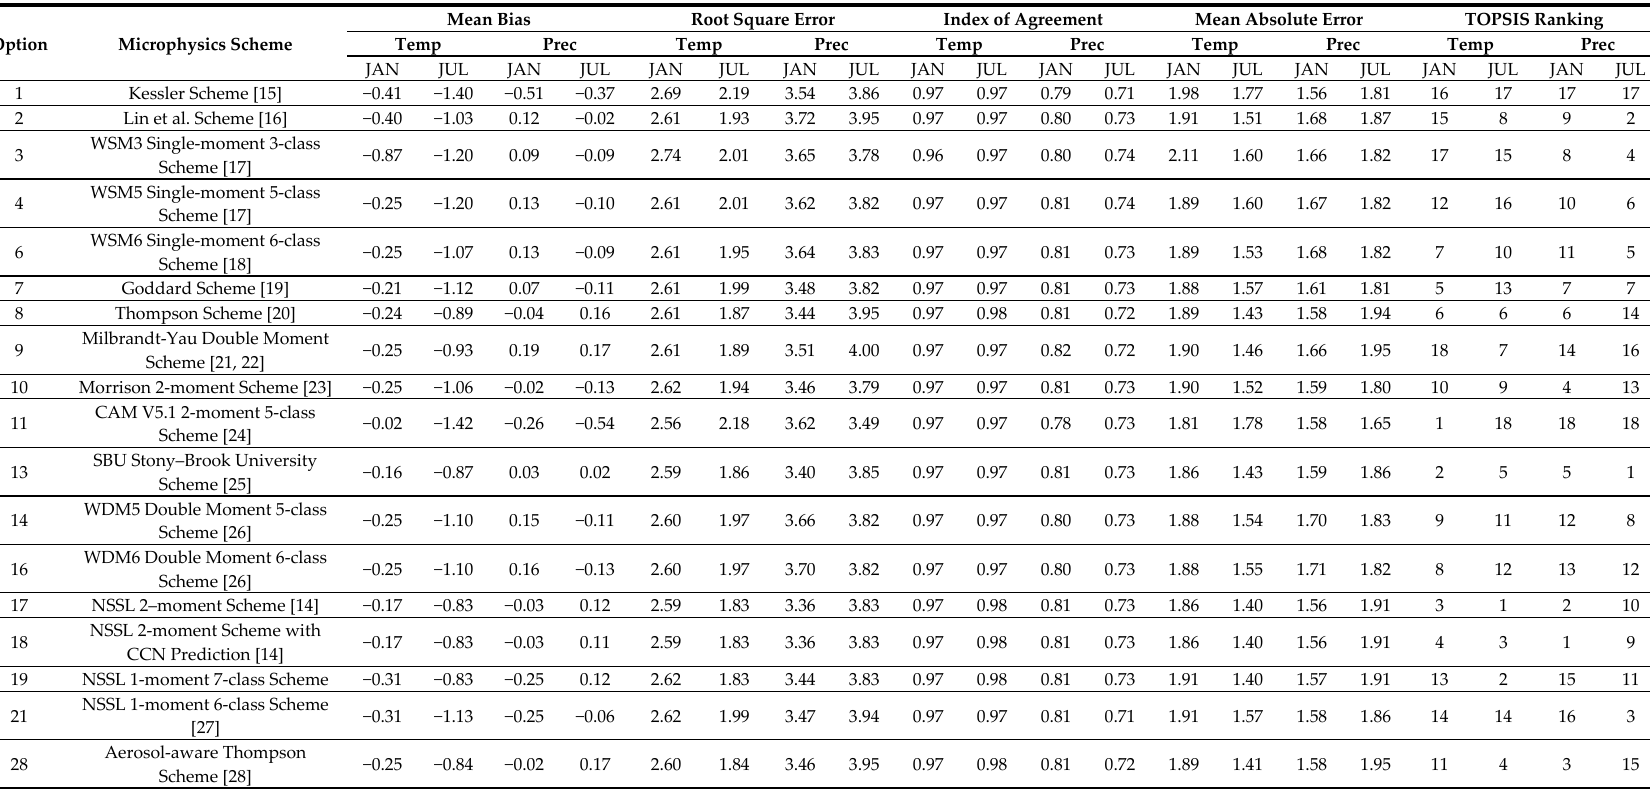
Table 2. Statistical measures and TOPSIS ranking for the Microphysics simulation